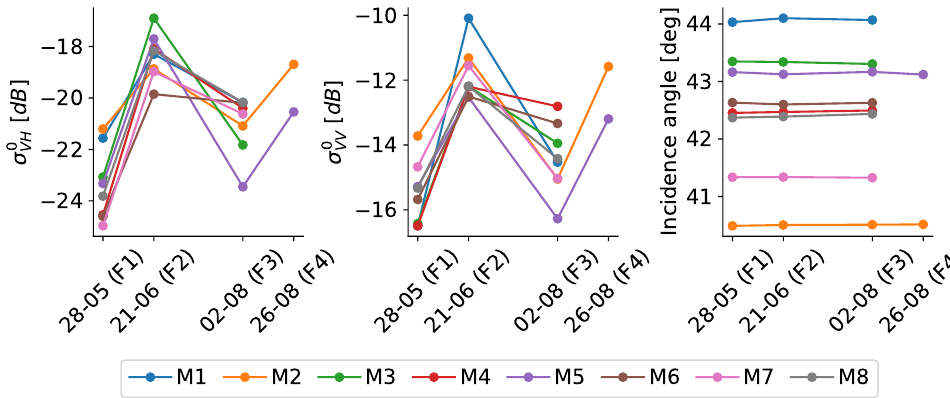
Figure 3. Time series of average C-band backscattering coefficient σ 0 and incidence angle from Sentinel- 1 (orbit 161, ascending) imagery. M1 to M8 designate the maize fields in which data were